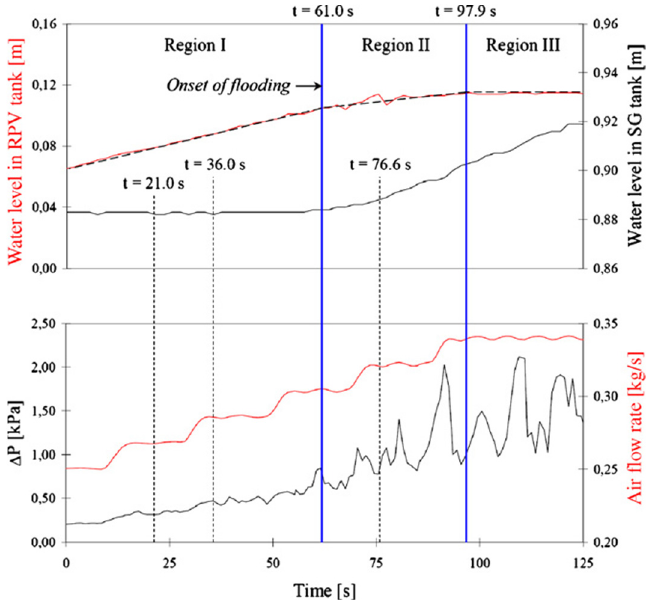
Figure 12. Variation of water level in the SG separator and in the RPV simulator, and of the pressure difference between the vessels and of the air mass flow rate measured at a water mass flow rate 𝑚(cid:4662) (cid:2896) = 0.3 kg/s (Deendarlianto et al. [1]).